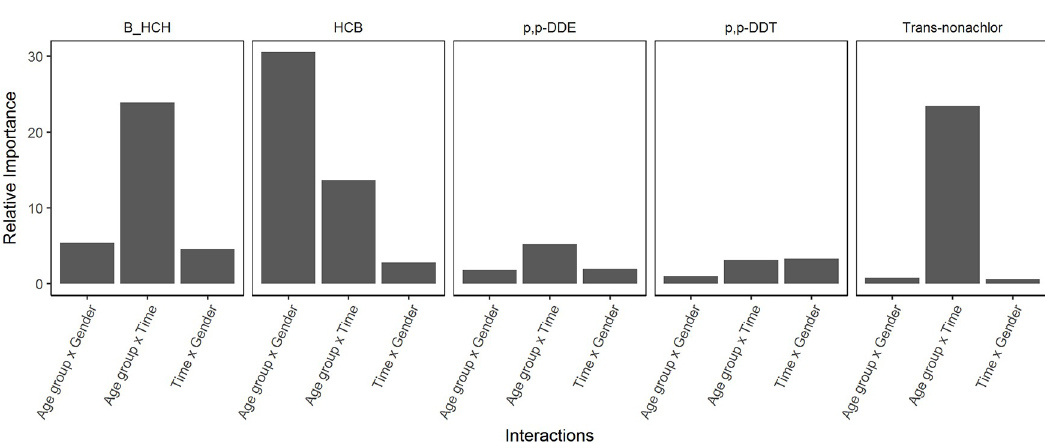
Fig 3. Graphical summary of relative importance of interactions in BRT models. Relative importance of interactions in predicting the concentrations of β -HCH, HCB, p,p’ -DDE, p,p’ -DDT and Trans-nonachlor based on a BRT analysis. The interactions from left to right are between age group and time, age group and gender, and time and gender.